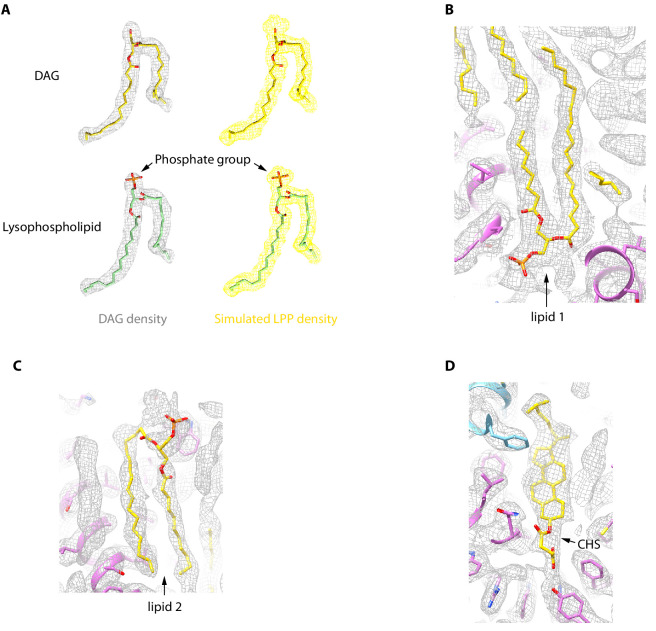
Lipid densities in human TRPC5 (hTRPC5) map.(A) Comparison of experimental density map of diacylglycerol (DAG) (gray) (contoured at 3.2 σ) and simulated density map of lysophospholipid (yellow). Please note, the density for electron-dense phosphate head group is absent in the cryo-EM maps obtained experimentally. (B–D) Close-up views of lipid 1 (B), lipid 2 (C), and cholesteryl hemisuccinate (CHS) (D) binding sites. Subunits A and B are colored in purple and light blue, respectively. Residues that interact with lipids are shown as sticks. Insets show cryo-EM densities of these lipids, contoured at 2.3, 3.1, and 3.1 σ, respectively.